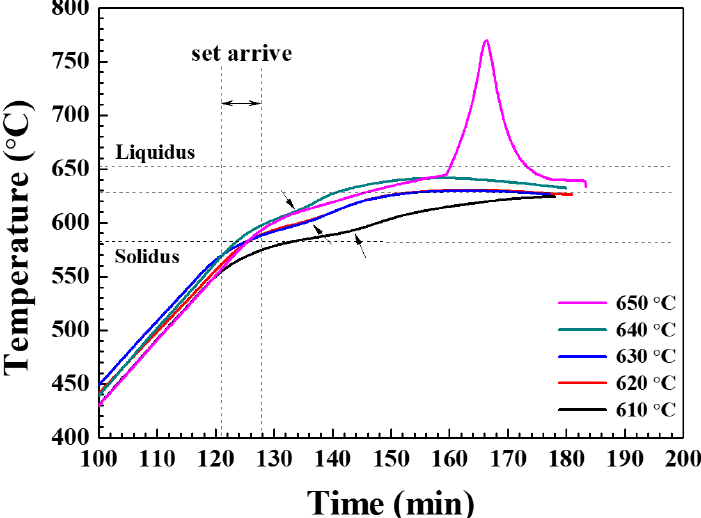
Figure 7. The temperature variation of 20 vol.% SiC (40 μ m)/Al 6061 composites during heating at various set temperatures (610–650 °C) under a fixed nitrogen flow rate of 4 L/min. various set temperatures (610–650 ◦ C) under a fixed nitrogen flow rate of 4 L /